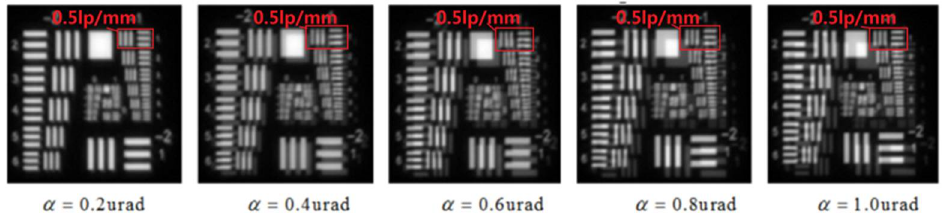
Figure 8. Simulated imaging with different tilt errors.